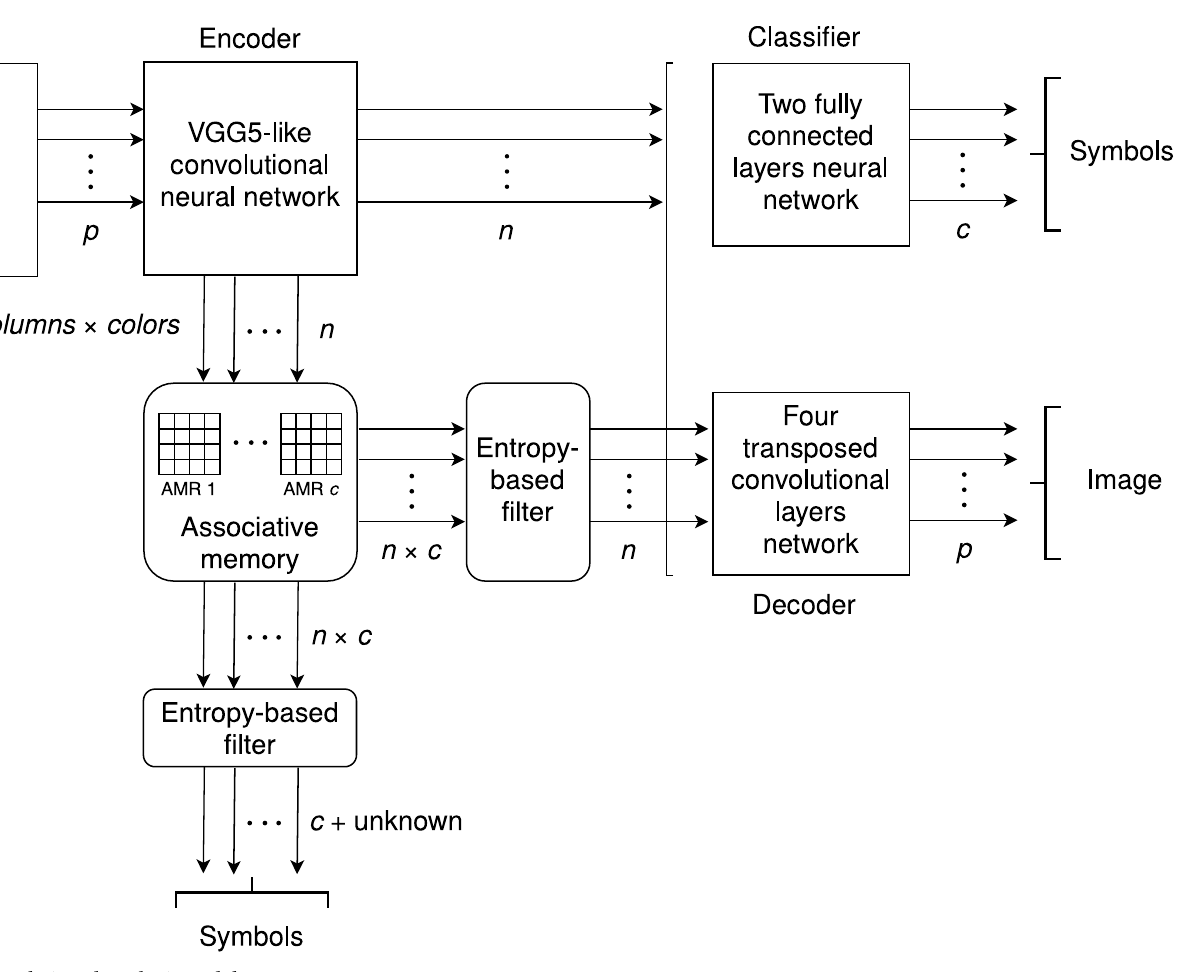
Fig 4. Training the analysis and synthesis